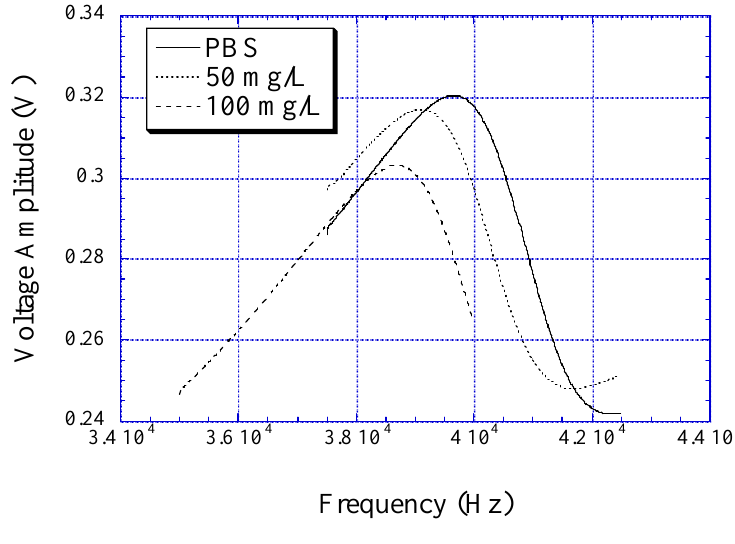
Figure 6. Frequency spectrum of a magnetoelastic glucose sensor as a function of glucose concentration.